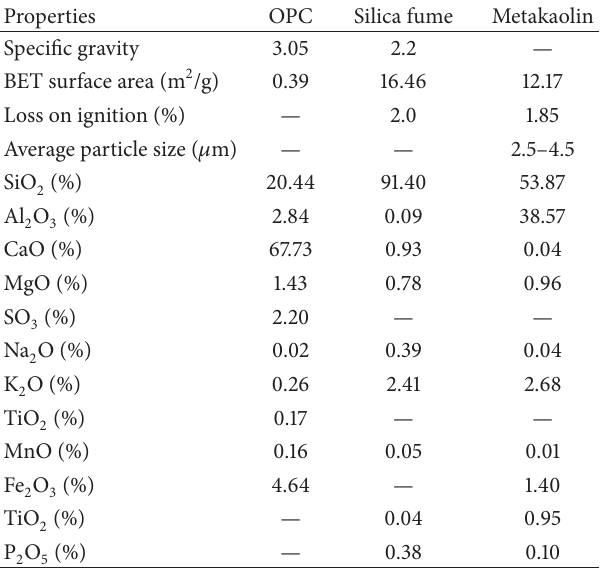
Table 1: Physical and chemical composition of OPC, silica fume, and